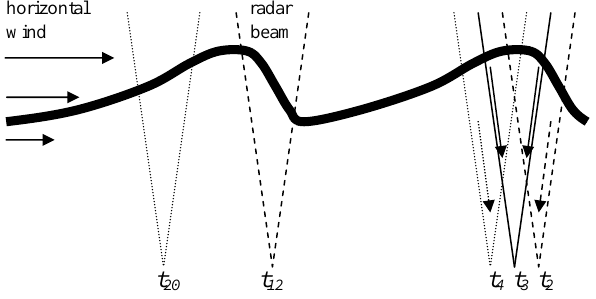
Figure 4. A wavy layer structure in a wind-sheared atmosphere. Radar beam is vertical. t n denotes different observational times corresponding to the time slots indicated in Fig. 2(d).